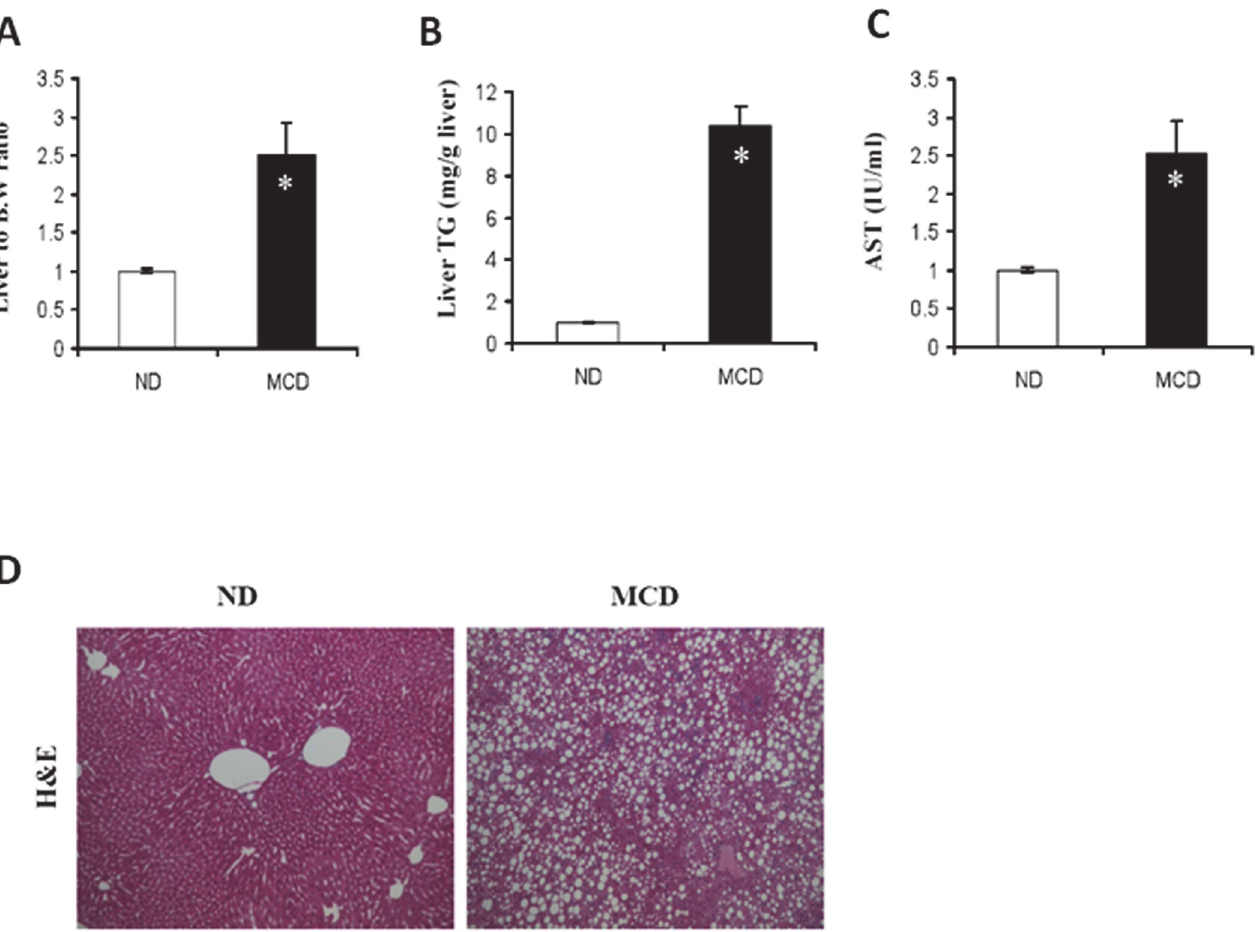
Fig 1. Effect of MCD diet on weight loss and hepatocellular damage. (A) Ratio of liver to body weight, (B) Hepatic triglyceride, and (C) AST values were analyzed in mice fed the ND or MCD diet. A significant increase in serum AST levels was observed in MCD-fed mice. Mean ± SD of results from ND (n = 5), MCD (n = 10). (D) The histology of liver sections from a ND, MCD by Hematoxylin-eosin (H&E) staining (original magnification